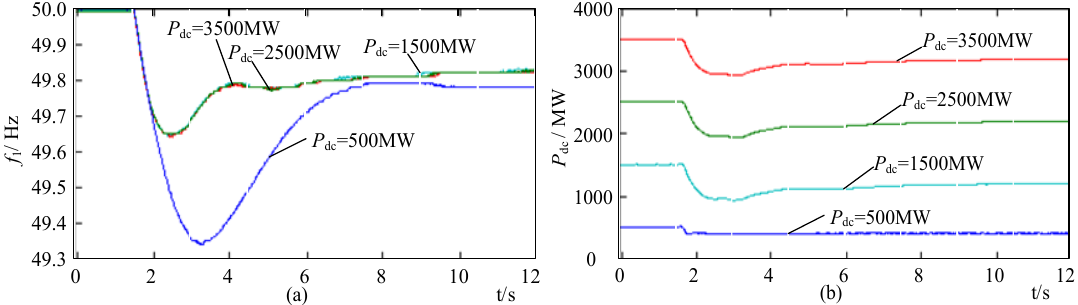
Figure 17. Response characteristics with different DC power. ( a ) The frequencies of the sending-end system; ( b ) the actual power transmitted by the UHVDC.